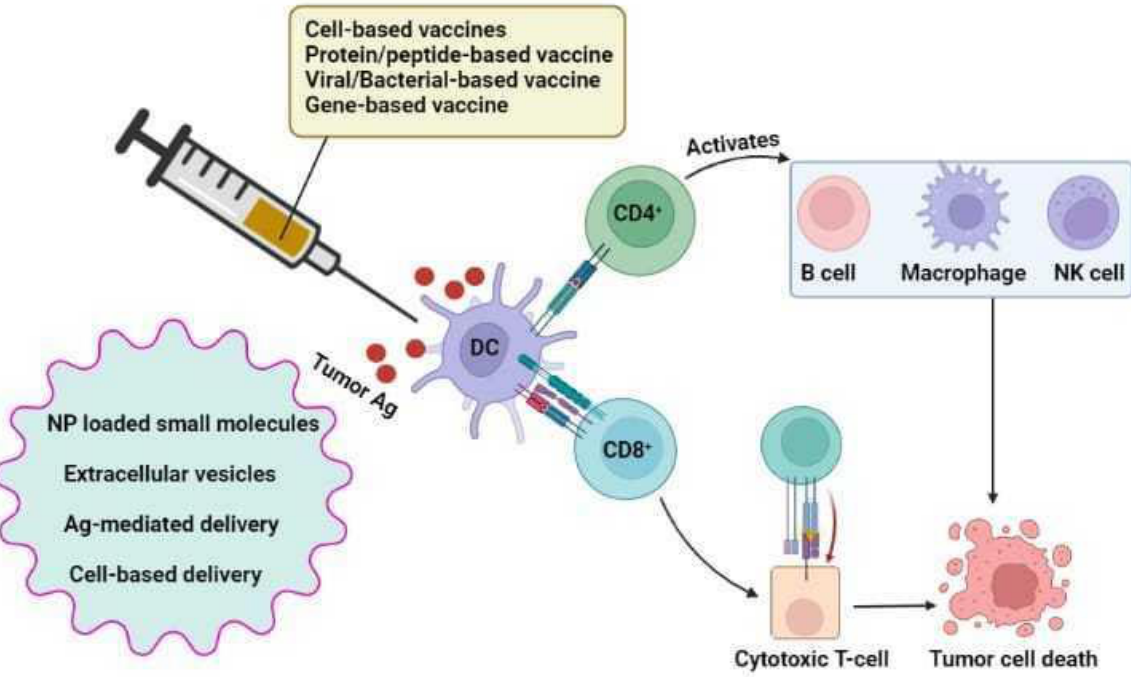
Figure 2. DCs get activated upon vaccine injection and move to the lymph node, wherein antigens are presented to T cells, which are then activated. As CD8+ cells mature because of cytokines released by CD4+ cells, they travel to the cells displaying the target antigen and execute a cytotoxic antitumor response.